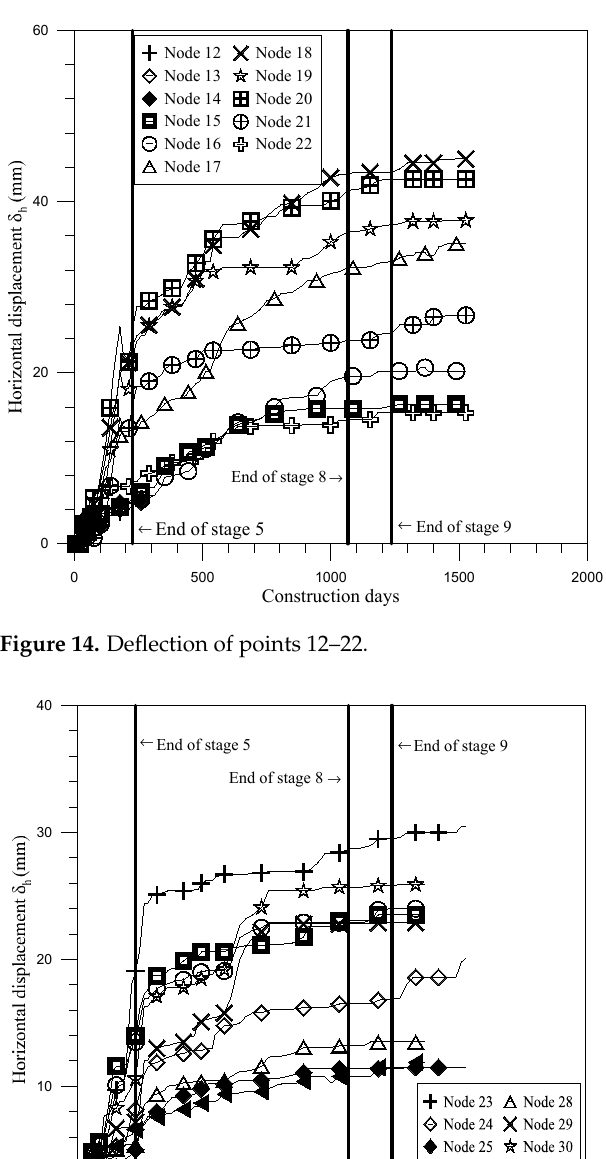
Figure 13. Deflection of points 0–11.